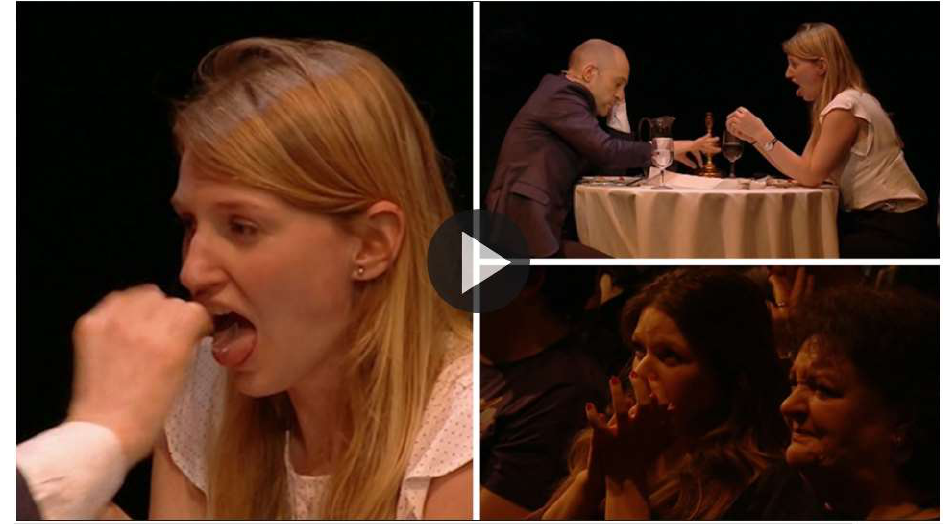
Figure 5. Fear on the face of guests as Derren Brown magically gets them to eat what looks like a shard of glass from a broken light bulb. Is one of the reasons that magical food experiences are so rare, the fact that so many examples of magic in mouth are gruesome/unpleasant. The fear is palpable on the face of the audience [77].